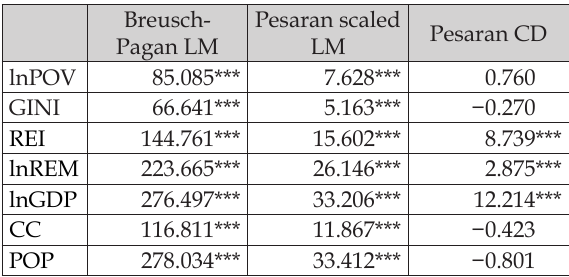
Table 5. Cross-sectional dependence results.